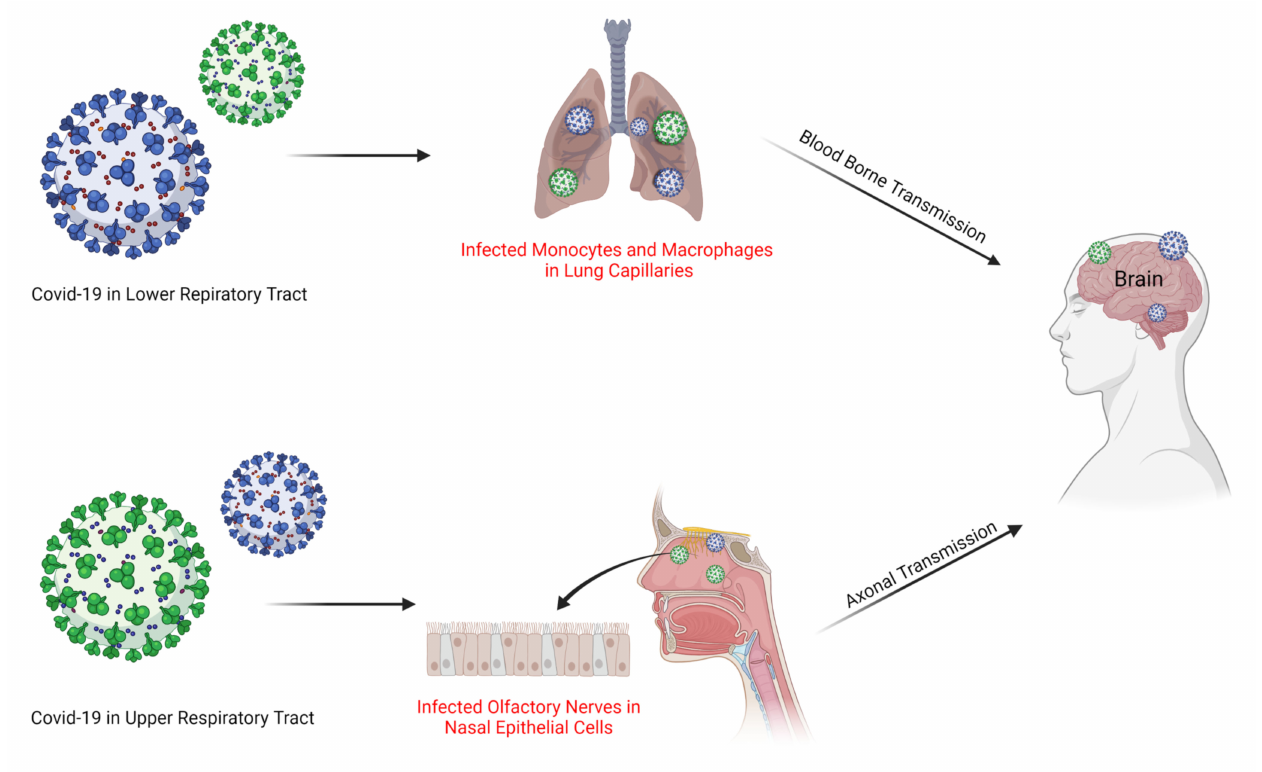
Figure 2. Entry mechanisms of COVID-19 into the brain. The illustration shows the two main mechanisms responsible for the entry of the virus into the brain, i.e., through the lungs (blood born transmission) and the olfactory nerves (axonal transmission) in the epithelial